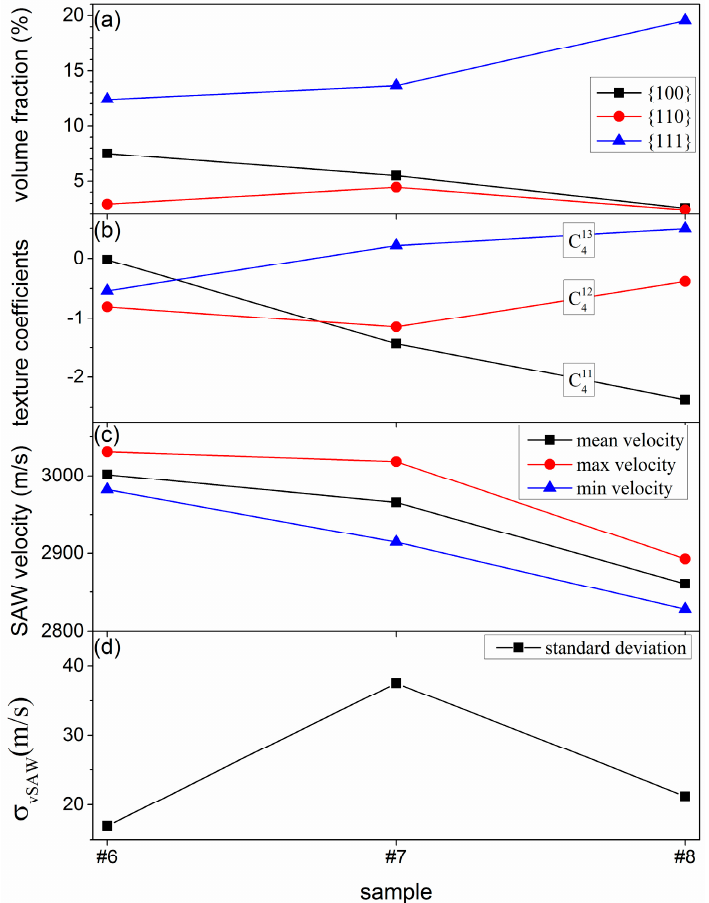
Figure 5. Characteristics of samples in the beginning (sample 6), during (sample 7) and after completion (sample 8) of recrystallization. ( a ) The volume fraction of the {100}, {110} and {111} textures; ( b ) the fourth order texture coefficients; ( c ) The maximum, minimum, mean values of SAW velocity; ( d ) the standard deviation of SAW velocity.